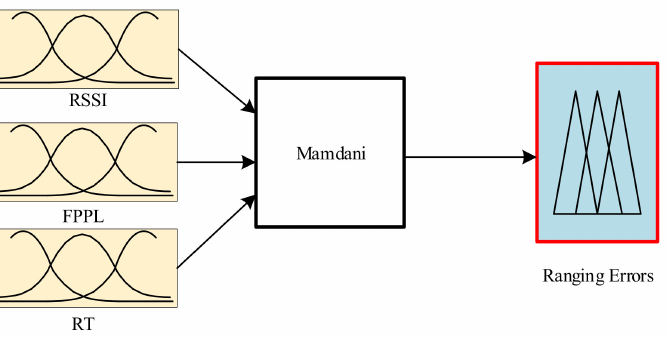
Figure 1. Structure of the fuzzy system for mitigating ranging errors based on the Mamdani